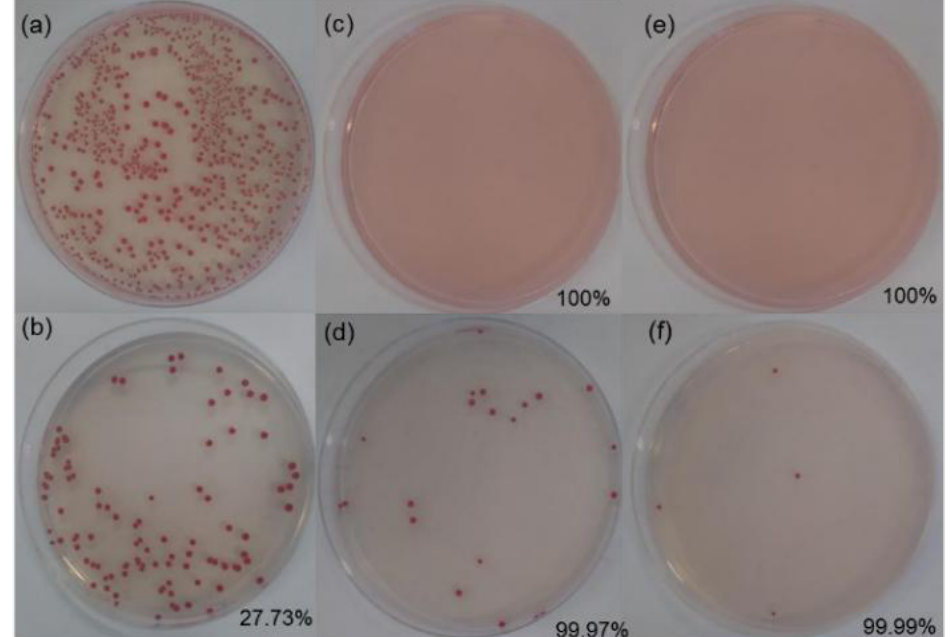
Figure 6. Antimicrobial activity (reduction of E. coli under dynamic contact conditions): ( a ) positive control; ( b ) woolen fabric; wool@HKUST-1 synthesis of: ( c ) 24 h; ( d ) 24 h washed; ( e ) 48 h; and ( f ) 48 h washed.